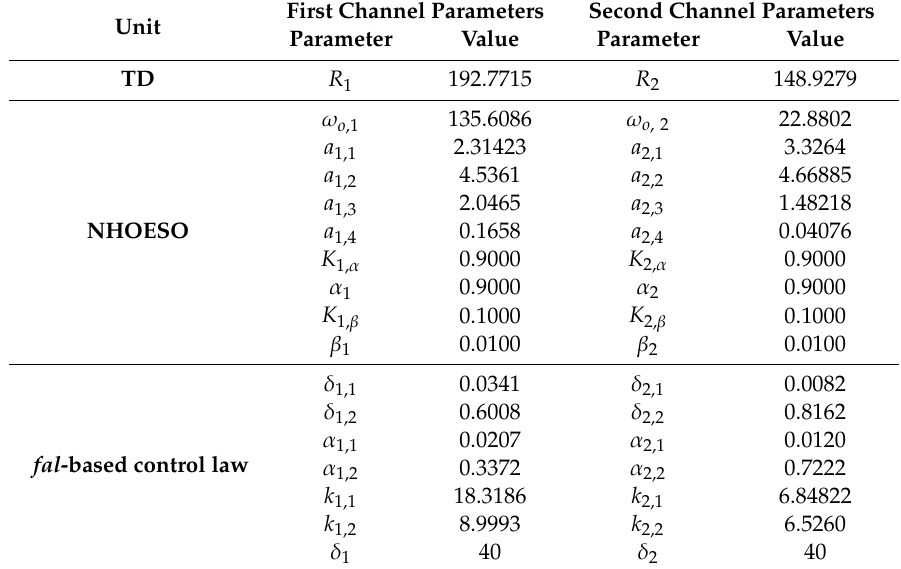
Table 2. The parameters of the second configuration (improved active disturbance rejection control (IADRC)) [23].